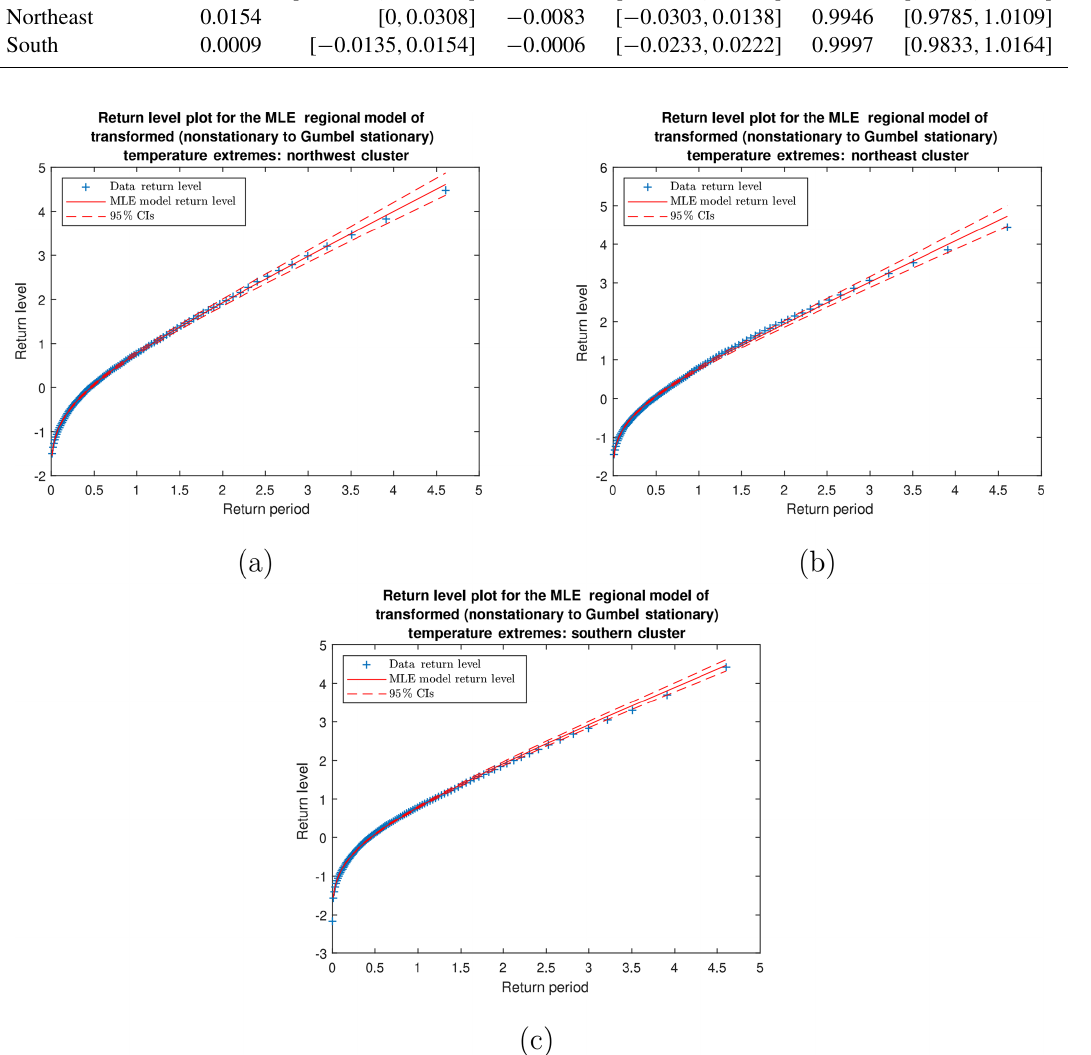
Figure 9. Return level plots comparing the parametric mixed GEV distribution with confidence intervals and actual mixed temperature maxima for the (a) northwest, (b) northeast, and (c) south clusters. These plots emphasize the regional model’s fit to the pooled